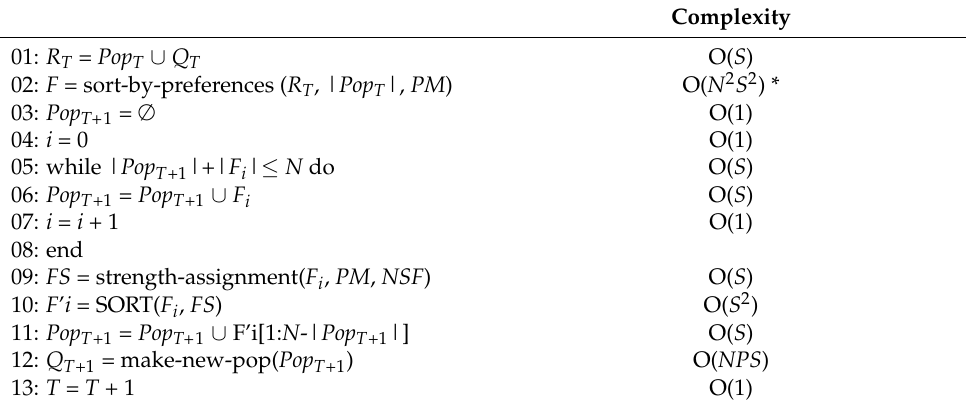
Table A1. I-NOSGA time complexity analysis.